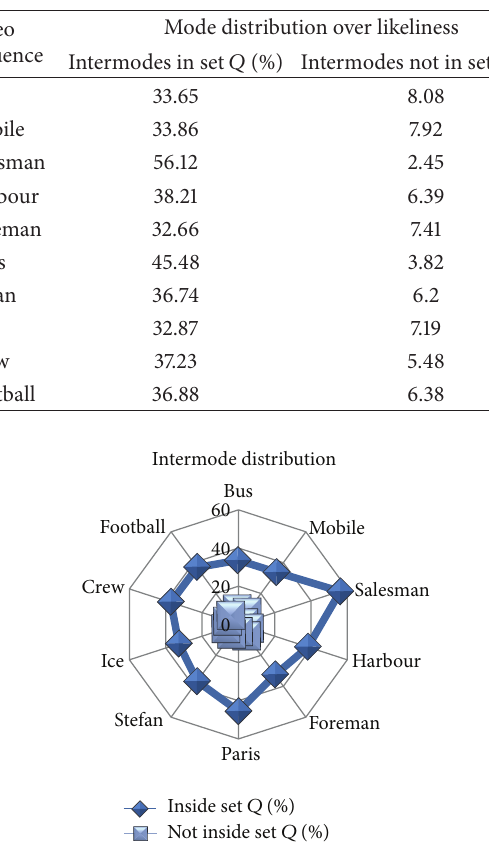
Figure 1: Intermode distribution over average